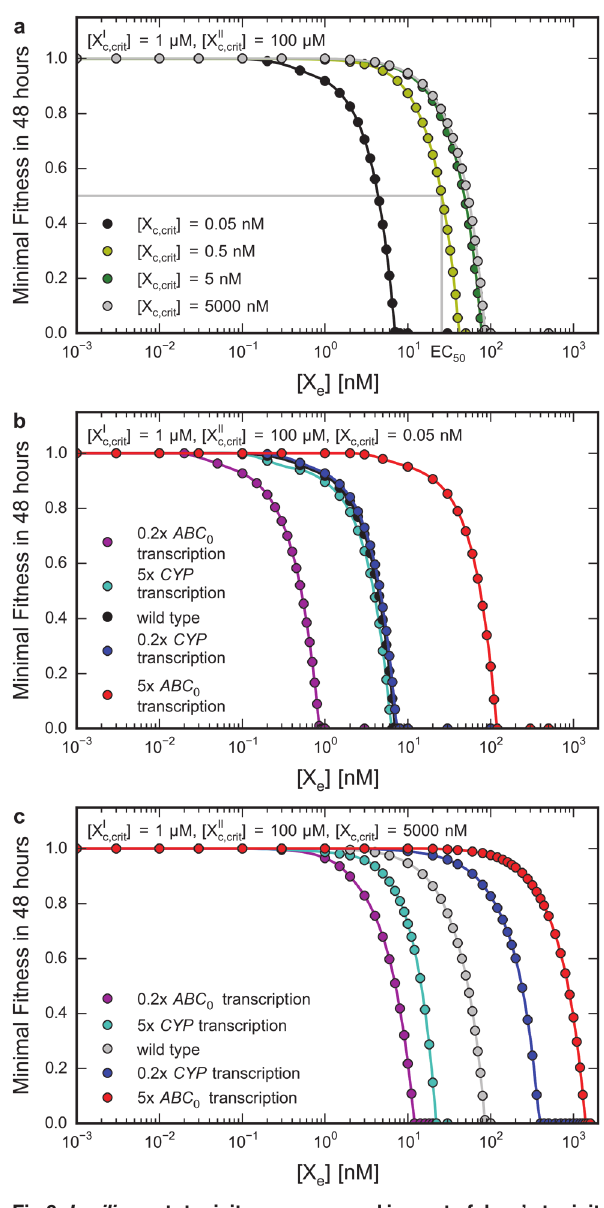
Fig 6. In silico cytotoxicity curves reveal impact of drug ’ s toxicity profile and protein level on survival. Time course simulations were run for up to 48 hours from steady states belonging to different parameter sets and extracellular drug concentrations ([X e ], set at t 0 = 0 h) as described in Methods. The minimal Fitness values reached in simulations were plotted against [X e ] (colored circles; connected by interpolation curves — see S1 Text). Critical concentrations of X ’ c and X ” c are constant on all panels with values 1 μ M and 100 μ M, respectively. Critical concentration of X c ([X c,crit ]) is indicated on the panels. a Impact of the toxicity of the unmetabolized form of the drug ([X c,crit ]) on in silico cytotoxicity. In silico cytotoxicity curves were plotted for [X c,crit ] values from 0.05 nM to 5 μ M. The EC 50 value is indicated for [X c,crit ] = 0.5 nM. b Impact of transporter and oxidase levels on in silico cytotoxicity when X c is more toxic than X ’ c ([X c,crit ] = 0.05 nM). c Impact of transporter and oxidase levels on in silico cytotoxicity when X c is less toxic than X ’ c ([X c,crit ] = 5 μ M). In panels b and c in silico cytotoxicity curves were calculated after setting the transcription rates of ABC 0 or CYP 0.2 or 5 times of its original value (S3 Table) to model lower or higher expression levels.